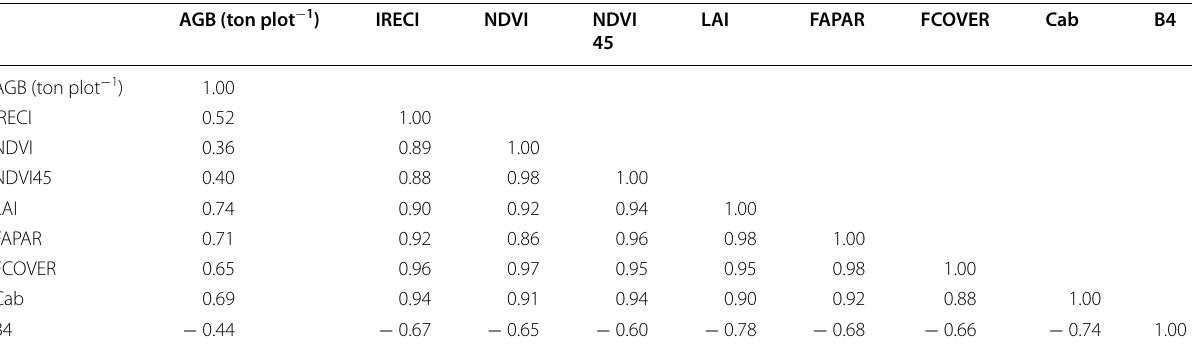
* Refers to plots located in the core zone of the biosphere reserve forest and ** refers to plots located in the buffer and transition zone of the biosphere reserve forest Table 6 Correlation between field measured above-ground biomass and selected vegetation index predictor